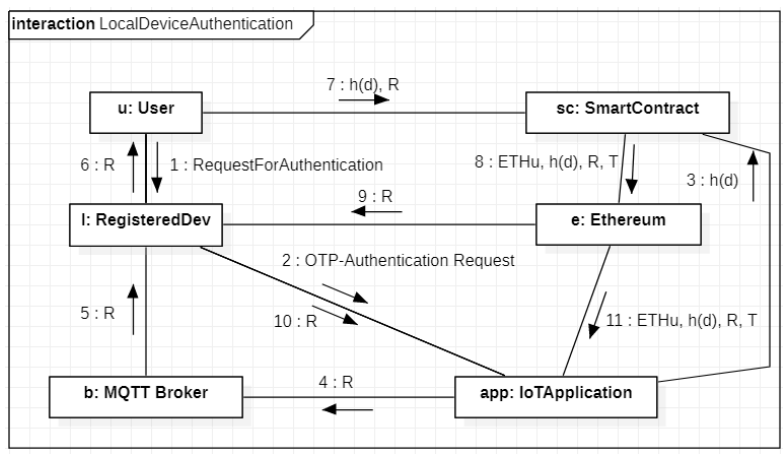
Figure 5. Authentication of a local